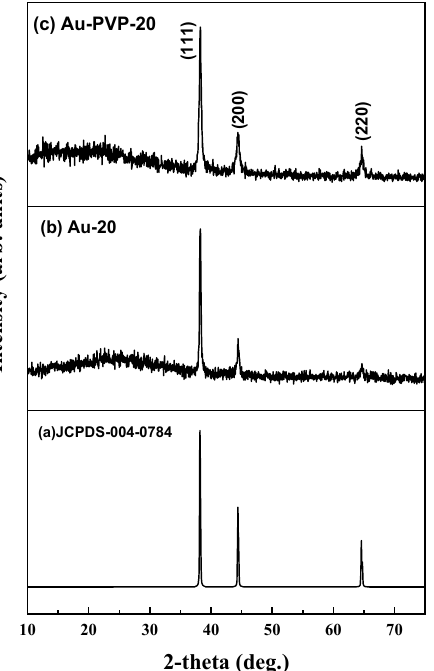
Figure 4. The Bragg’s reflections peaks of both samples appeared at 38.24 ◦ , 44.3 ◦ , and 64.7 ◦ , corresponding to (111), (200), and (220) planes, respectively, indicating the FCC lattice.